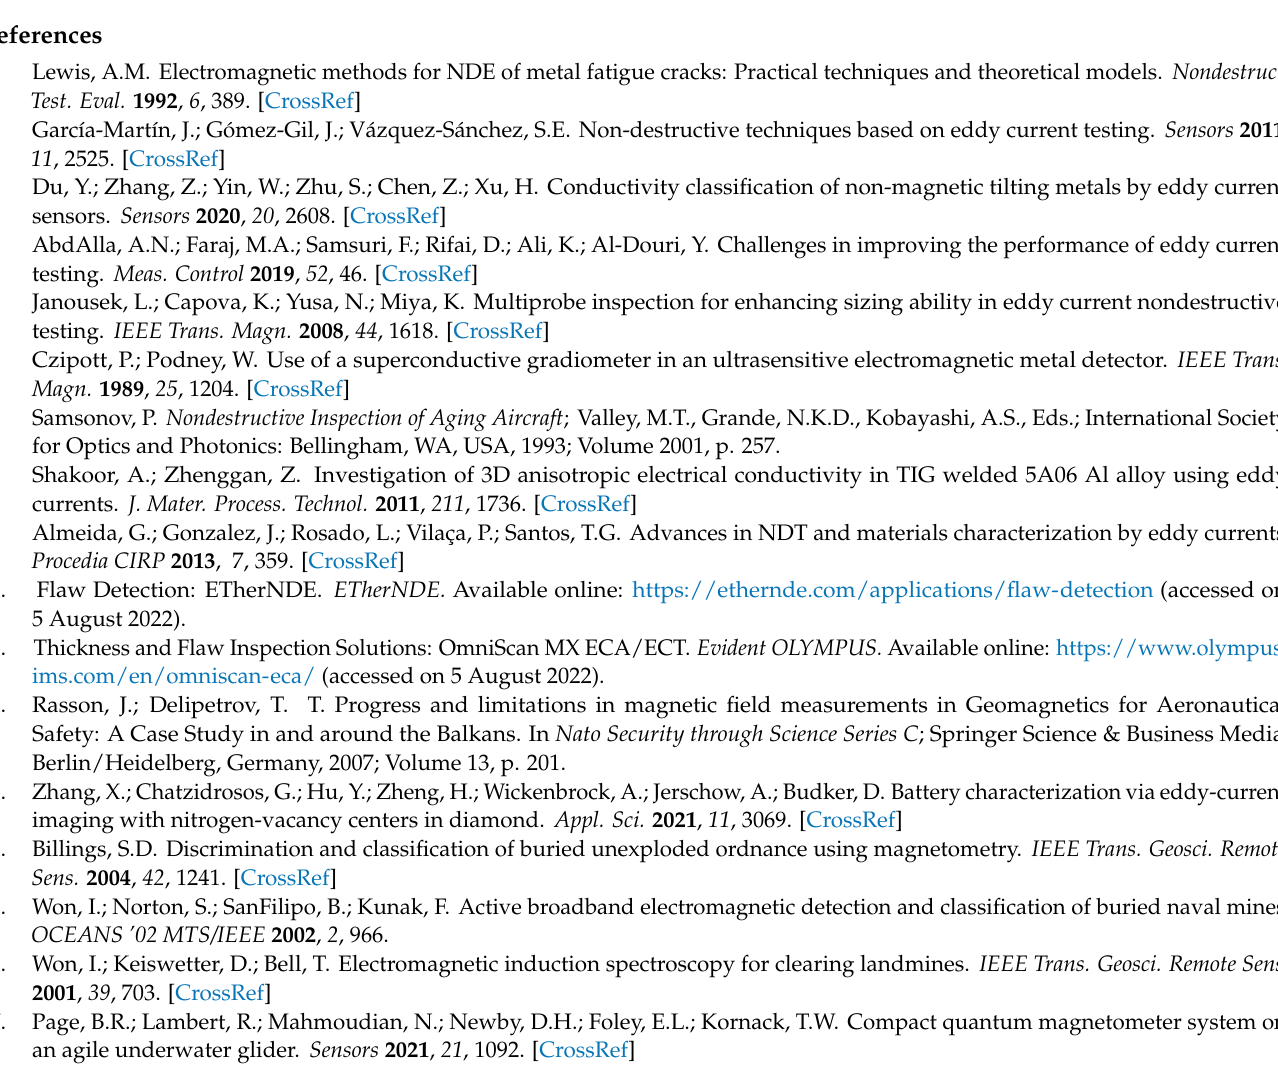
Figure A4. Fitting the conductivity and permeability of 440c steel using equations similar to those found in